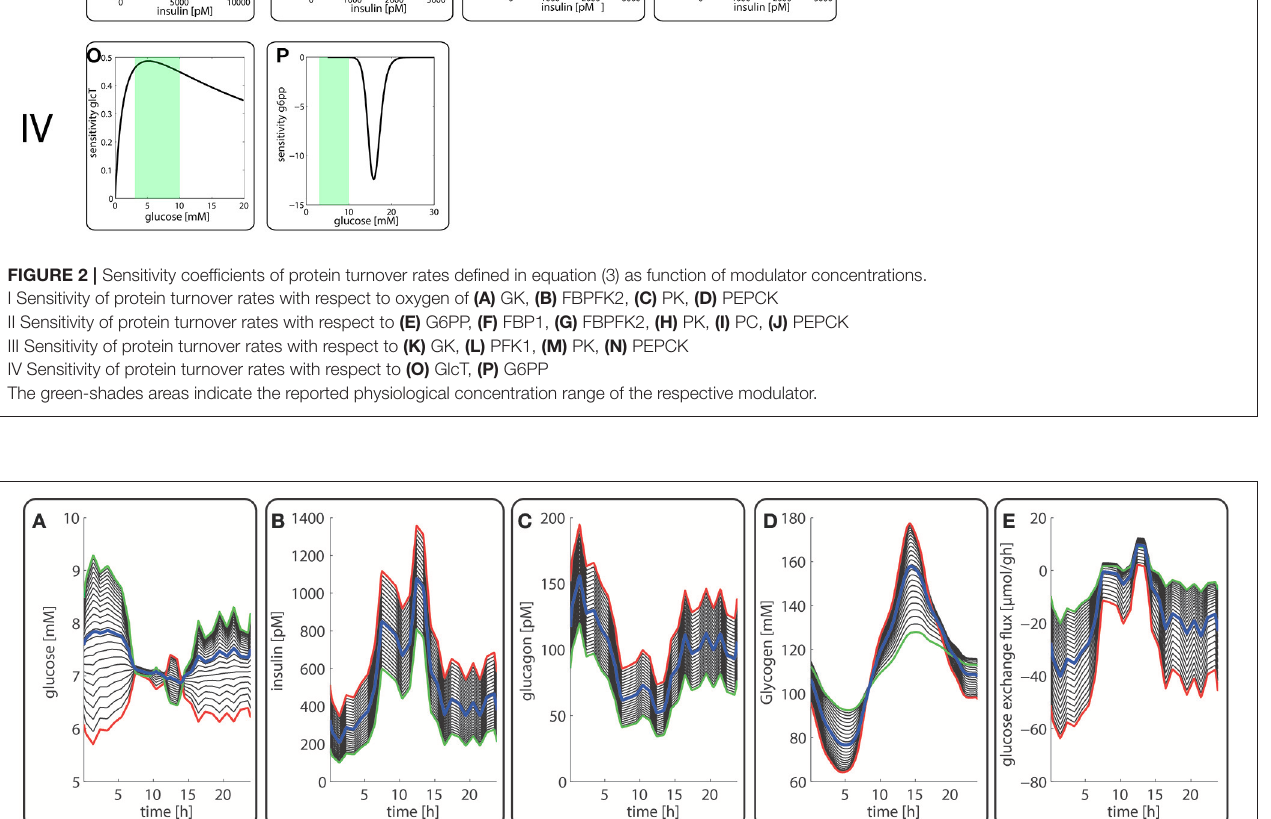
Frontiers in Physiology | www.frontiersin.org